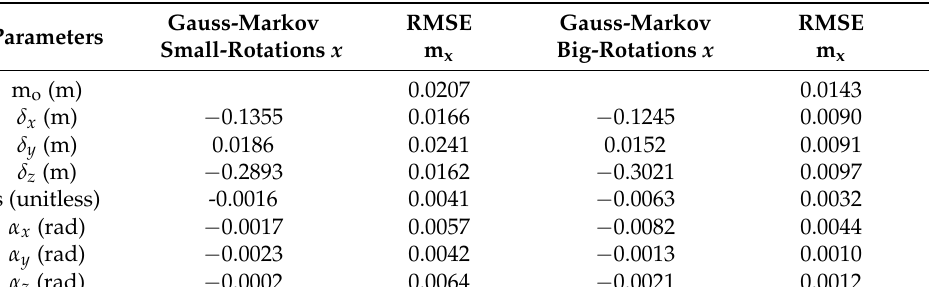
Table 4. Building facade: transformation parameters ( x ) with their RMSE ( m x ) in coarse registration with the new algorithm.